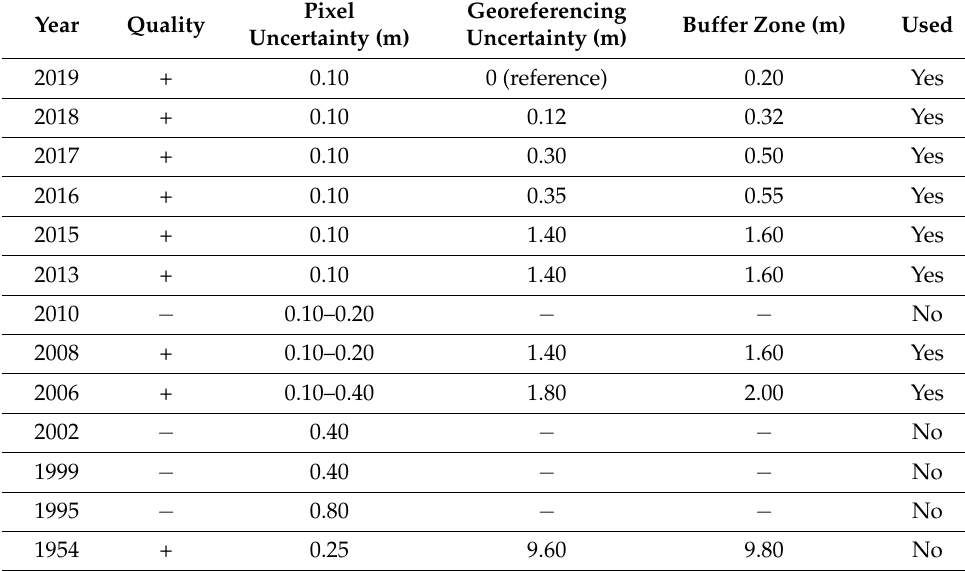
Table 1. Orthophoto